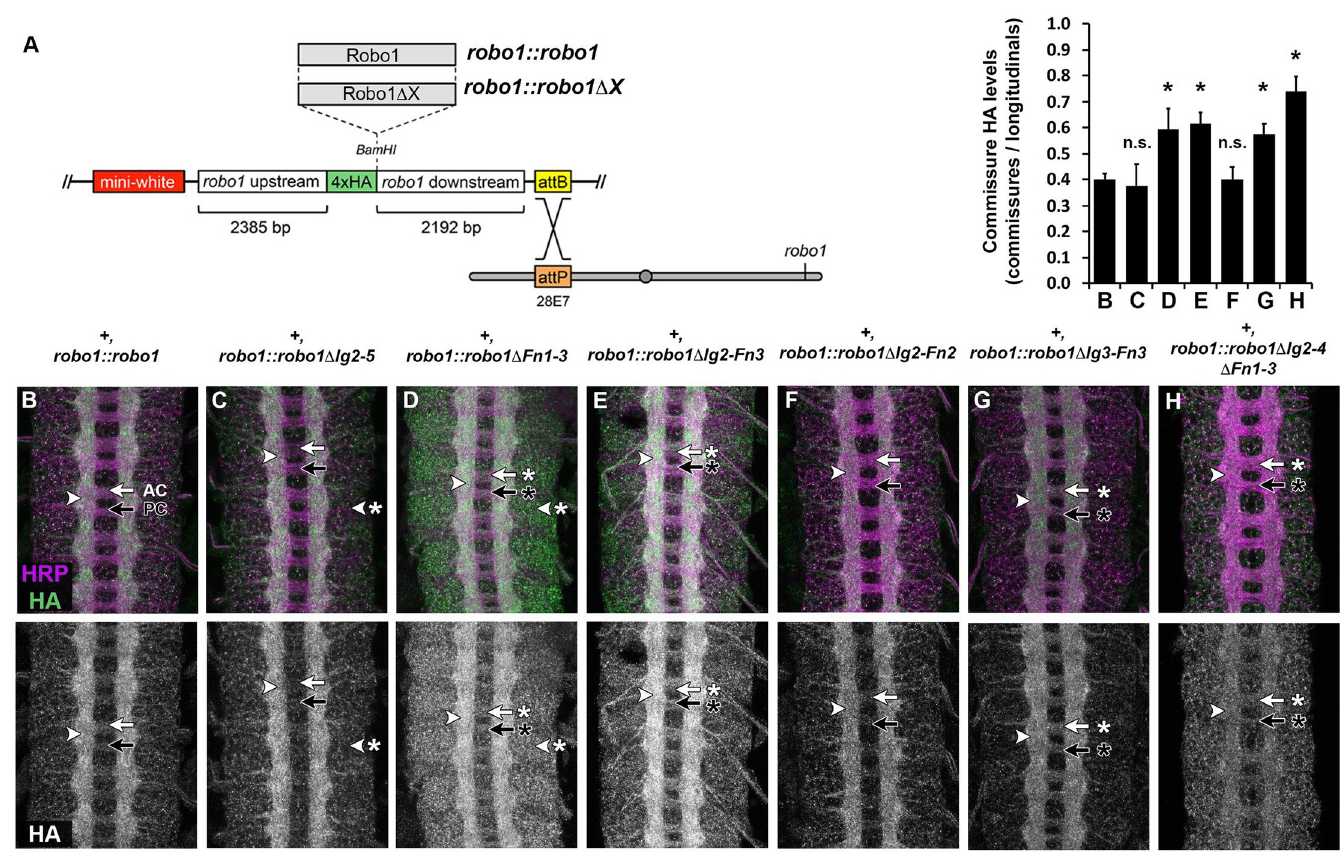
Fig 2. Robo1 Fn3 is required for commissural clearance. Expression of full-length Robo1 and Robo1 variants via the robo1 :: robo1 genomic rescue transgene in a wild type background. (A) Schematic of robo1 rescue construct. (B-H) Stage 16 embryos stained with anti-HRP (magenta) and anti-HA (green) antibodies. Bottom images show HA channel alone from the same embryos. HA tagged full-length Robo1 (B), Robo1 Δ Ig2-5 (C), Robo1 Δ Fn1-3 (D), Robo1 Δ Ig2-Fn3 (E), Robo1 Δ Ig2-Fn2 (F), Robo1 Δ Ig3-Fn3 (G), or Robo1 Δ Ig2-4 Δ Fn1-3 (H) proteins expressed from the robo1 rescue transgene are localized to longitudinal axon pathways (arrowhead). However, variants lacking Fn3 [Robo1 Δ Fn1-3 (D), Robo1 Δ Ig2-Fn3 (E), Robo1 Δ Ig3-Fn3 (G) and Robo1 Δ Ig2-4 Δ Fn1-3 (H)] are present on commissural axon segments in the anterior commissure (AC, white arrow with asterisk) and posterior commissure (PC, black arrow with asterisk) to a higher degree than full-length Robo1(B), Robo1 Δ Ig2-5 (C) or Robo1 Δ Ig2-Fn2 (F). Elevated expression in neuronal cell bodies is seen in Robo1 Δ Ig2-5 (D) and Robo1 Δ Fn1-3 (E) (arrowhead with asterisk). Bar graph quantifies the ratio of HA levels on commissural axons vs longitudinal axons for the genotypes shown in B-H (error bars show s.d.). Extent of commissural clearance for each Robo1 variant (C-H) was compared to full-length Robo1 (B) by a two-tailed Student’s t-test with a Bonferroni correction for multiple comparisons ( � p < 0.0001 compared to robo1 :: robo1 ). n = 3 embryos per genotype.